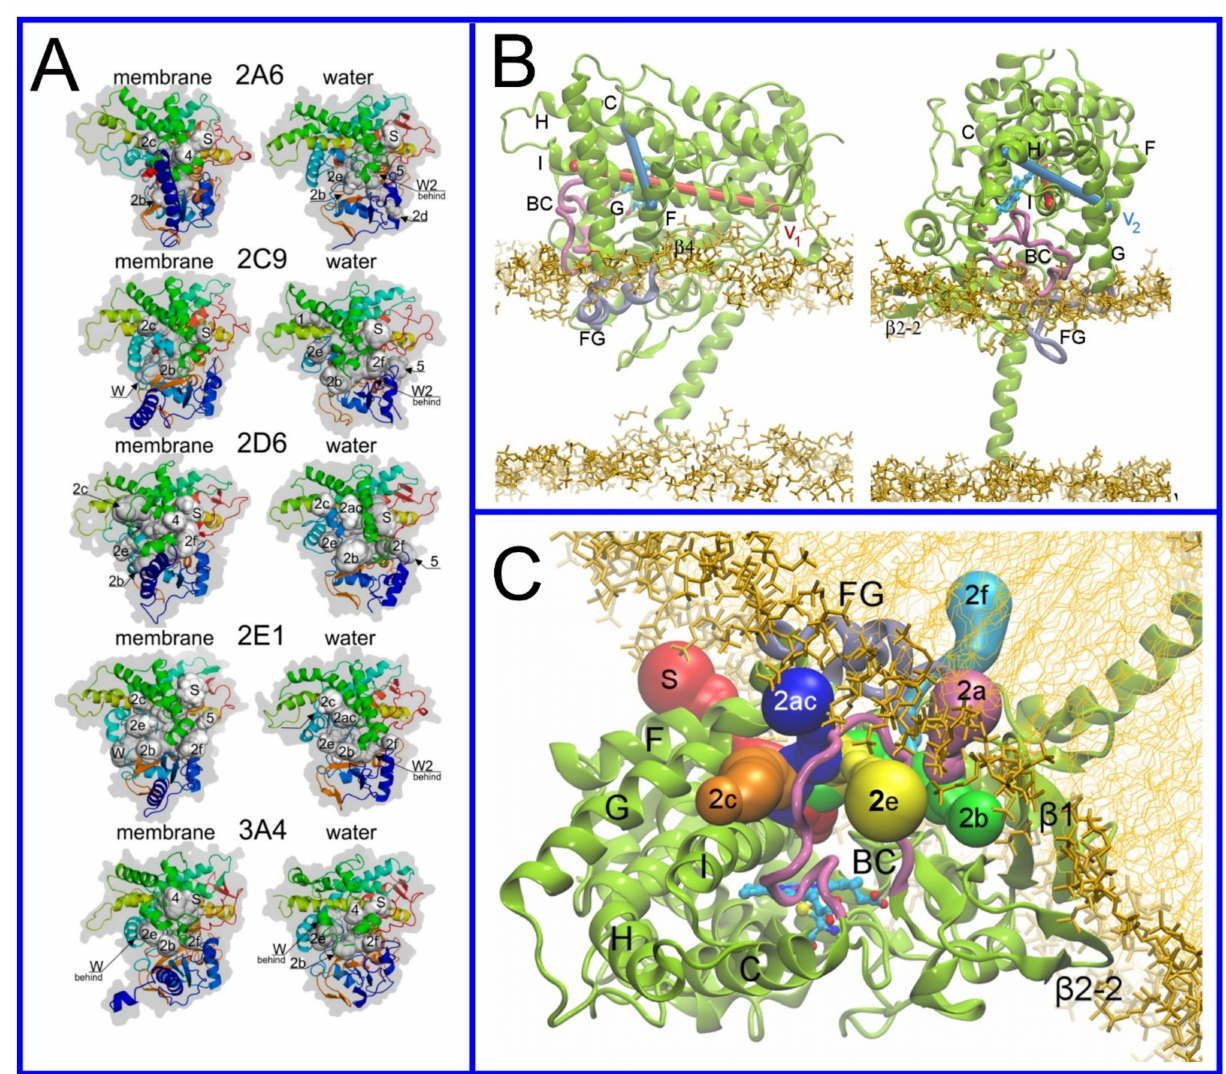
Figure 21. ( A ) Snapshots of five CYP enzymes simulated attached to the membrane (left) and simulated in water (right) with open (minimum radius 1.5 Å) channels shown. Reproduced with permission from ref. [962]. ( B ) Snapshots of the models of membrane-bound CYP 2C9 and ( C ) visualization of the channels observed in MD simulations of these models. Reproduced with permission from ref.